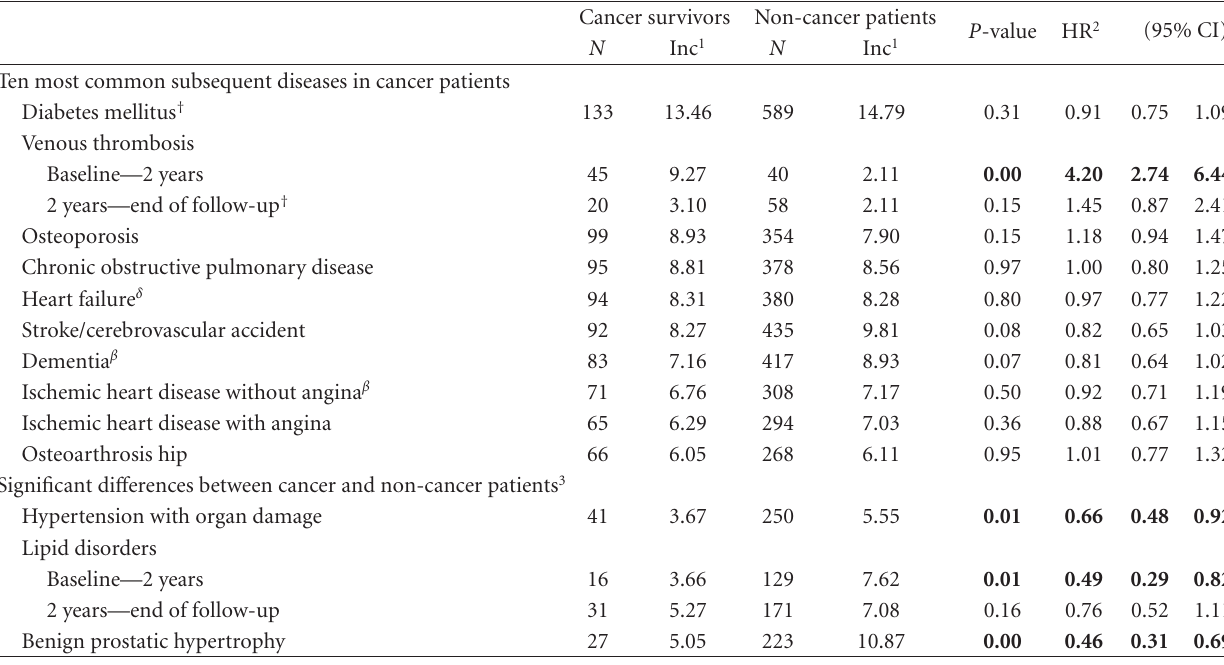
Table 3: Subsequent chronic diseases in men and